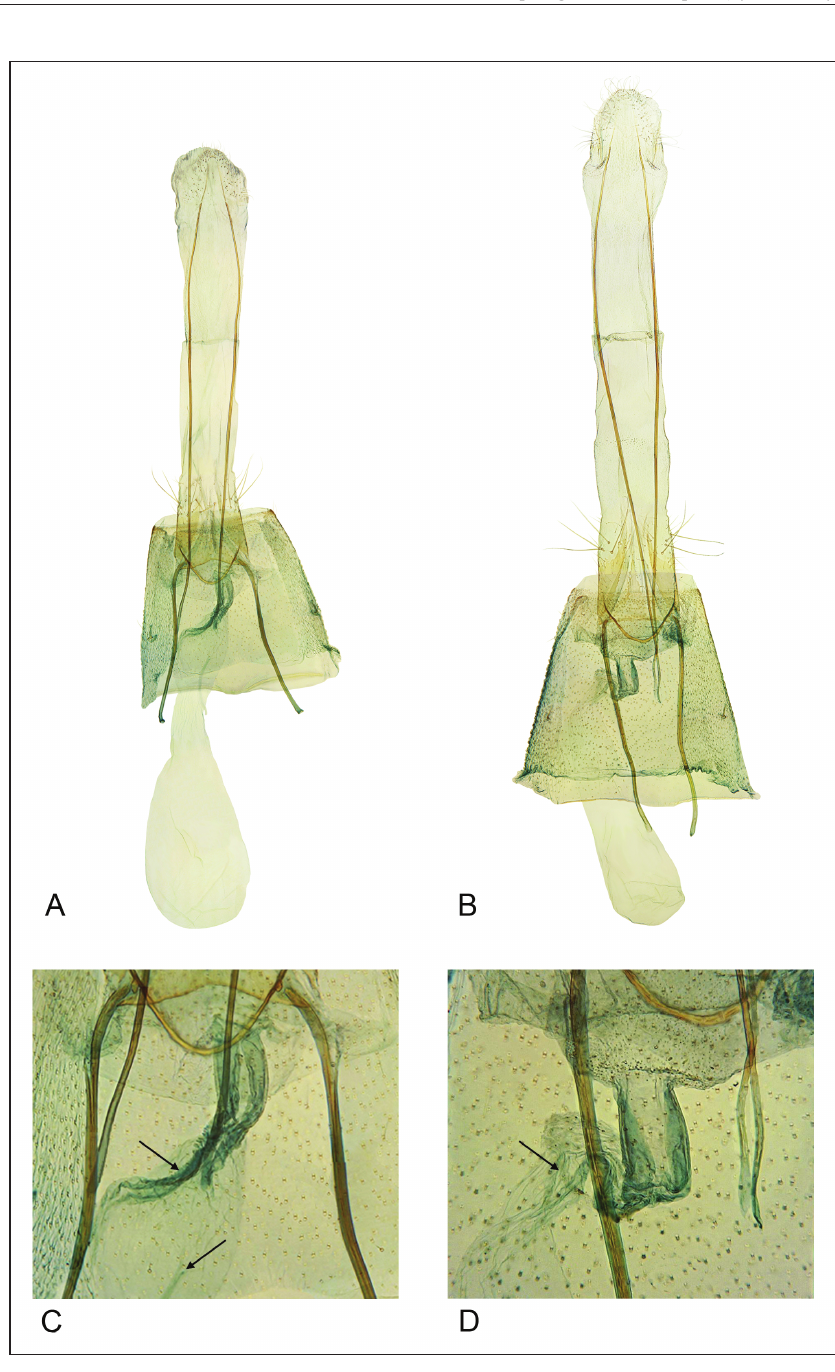
Figure 3. Female genitalia in A. gambronensis sp. n. ( A, C ) and A. kurdistanella Amsel ( B, D ). A, B ) genitalia in ventral view, C, D ) middle part of genitalia. Upper and lower arrows in figure C indicate the folded area at the anterior end of ductus bursae and locus of origin of the ductus seminalis, respectively and in figure D indicates the locus of origin of the ductus